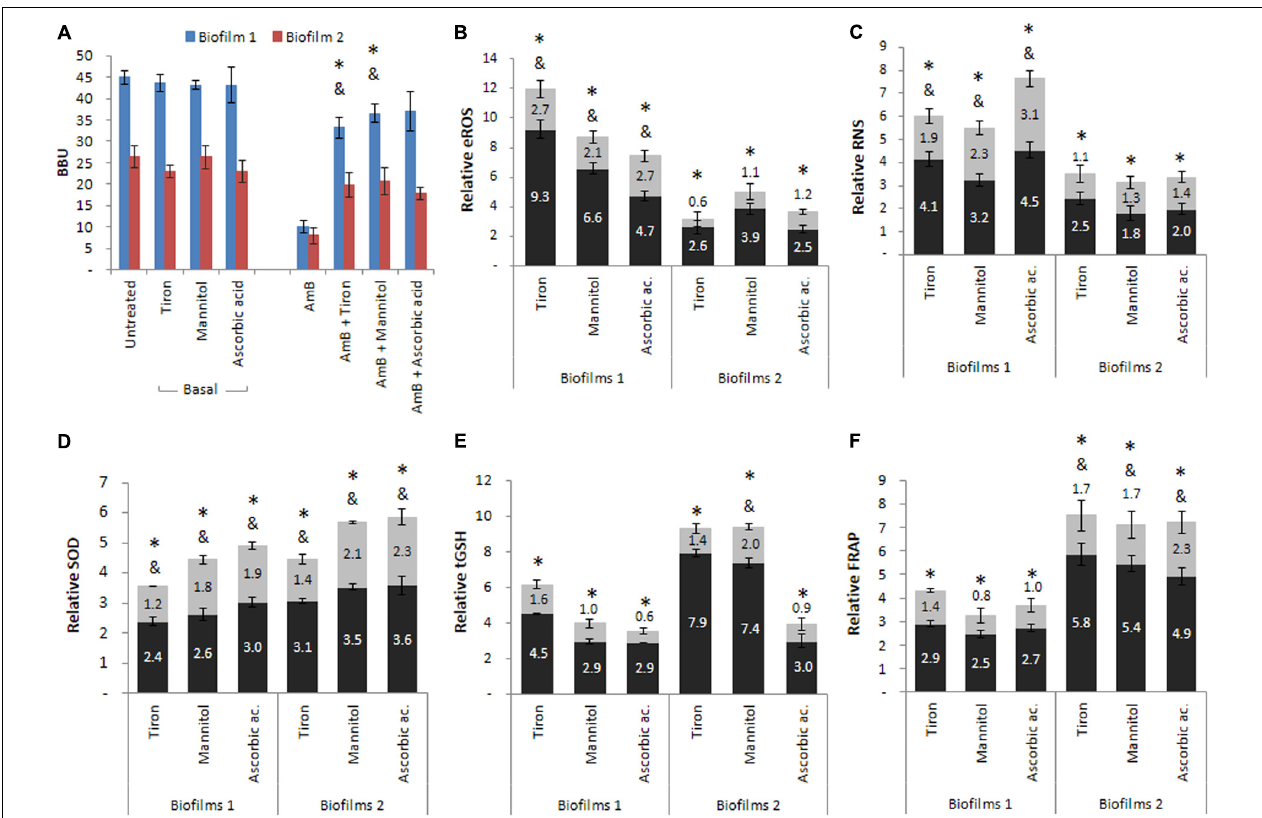
FIGURE 5 | Cellular stress metabolites and oxidative stress responses (OSR) of biofilms 1 (B1) formed from planktonic culture and of biofilms 2 (B2) formed from persister cells (PCs) co-incubated in the presence of three reactive oxygen species (ROS), quencher or scavengers. Tiron, mannitol and ascorbic acid were added to (A) B1 and B2, and the (B) extracellular reactive oxygen species (eROS), (C) reactive nitrogen species (RNS), (D) superoxide dismutase (SOD), (E) total reduced glutathione (tGSH) and (F) total antioxidant system were determined by the ferrous reduction antioxidant power (FRAP) assay. Black bars correspond to AmB treated conditions relative to the basal condition and gray bars correspond to AmB plus quencher condition relative to the corresponding basal condition. All experiments were performed in triplicate, for three independent experiments, and the numerical data are presented as means ± standard deviation. *denotes statistical significance at p < 0.01 for comparisons between conditions basal and AmB, and & denotes statistical significance at p < 0.01 for comparisons between basal and AmB plus quencher or scavengers conditions.